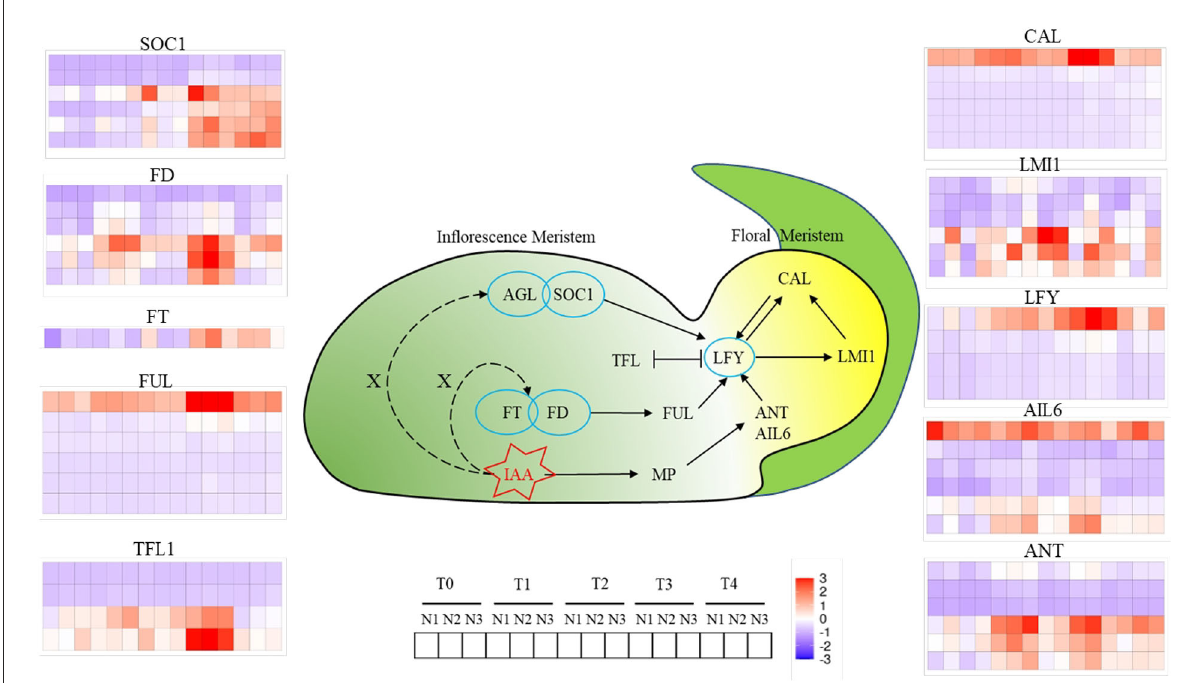
FIGURE5 Changes of genes involved in floral meristems identity genes at T0, T1, T2, T3, and T4 stages under low N (N1), formal N (N2), and high N (N3) rates. Color bars represented the trends of expression levels after centralization and standardization by R programming language and red color represents higher expression, while purple represents lower expression